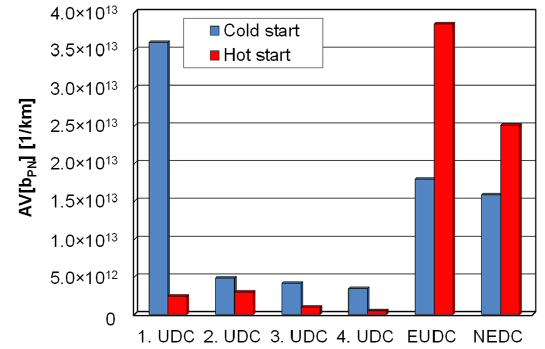
Figure 13. Average particle number emissions (AV[b PN ]) in four parts as well as in the NEDC test for cold and hot starts. The effect of cold starts on average road emissions of carbon dioxide (Figure 14) and road fuel mass consumption (Figure 15) were very similar. The biggest difference occurred in the first phase of the UDC test.